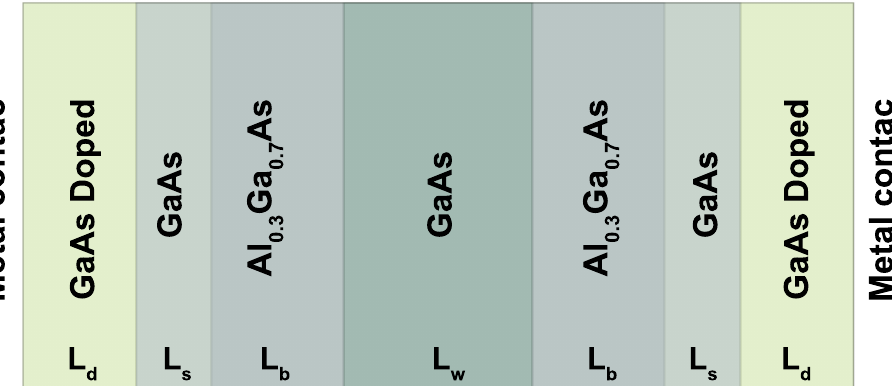
Figure 1. Scheme of the resonant tunneling diode (RTD), with doping n d in the outer regions, two Al 0.3 Ga 0.7 As barriers, a GaAs well, and two outer regions of the GaAs undoped with two metal contacts in the external